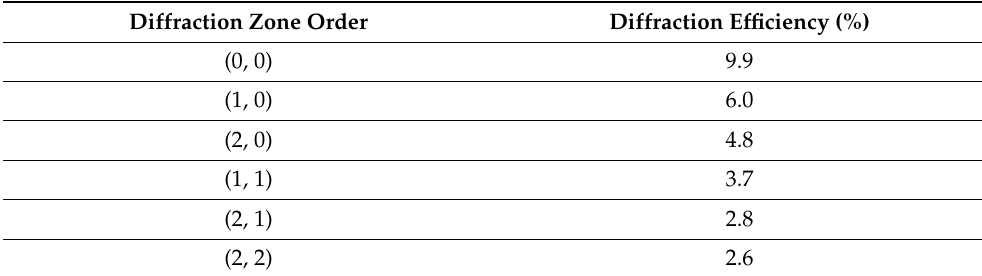
Table 1. Measured diffraction efficiency for some diffraction zone orders in Figure